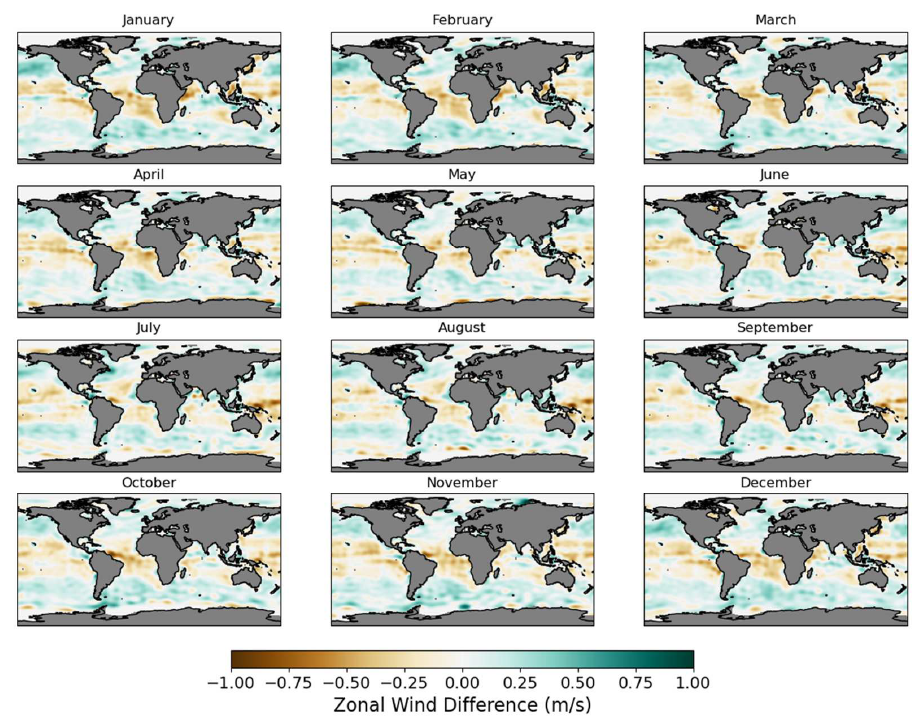
Figure A1. Maps of monthly zonal wind adjustments applied to speed-adjusted ERA5 winds.